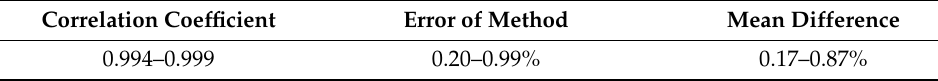
Table 7. Range of correlation, error (%) and mean difference (%) values. Correlation